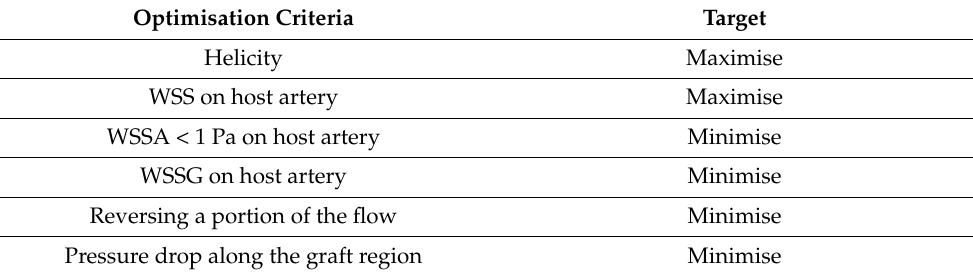
Table 1. Optimisation criteria